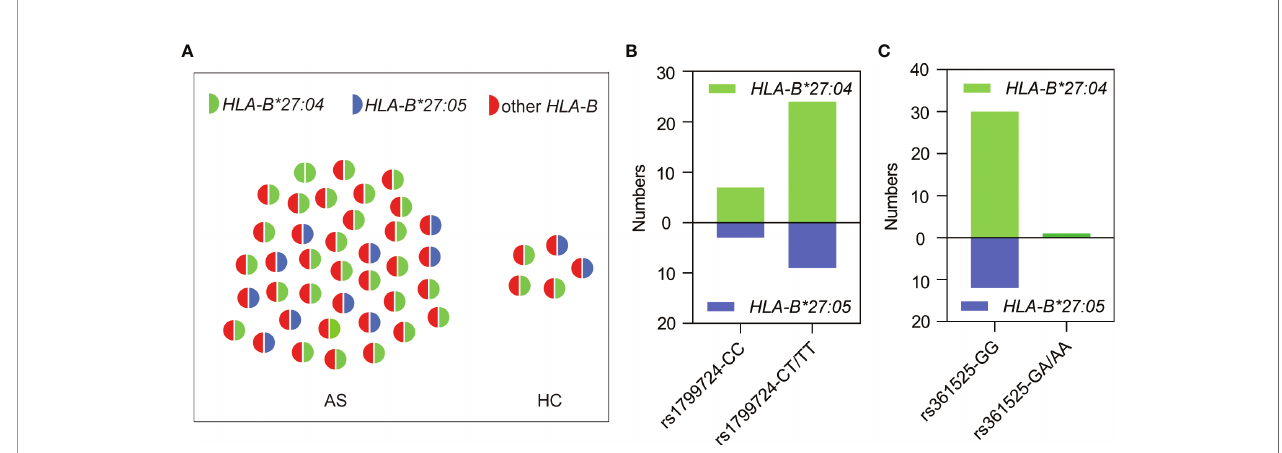
FIGURE 4 | Genotyping results of 43 HLA-B27-positive subjects. (A) HLA-B genotyping results of AS patients ( n = 38) and healthy controls ( n = 5). (B) Genotype distribution of rs1799724 in the subjects carrying HLA-B*27:04 or HLA-B*27:05 . (C) Genotype distribution of rs361525 in the subjects carrying HLA-B*27:04 or HLA-B*27:05 . Other HLA-B , other alleles of HLA-B but none of HLA-B*27